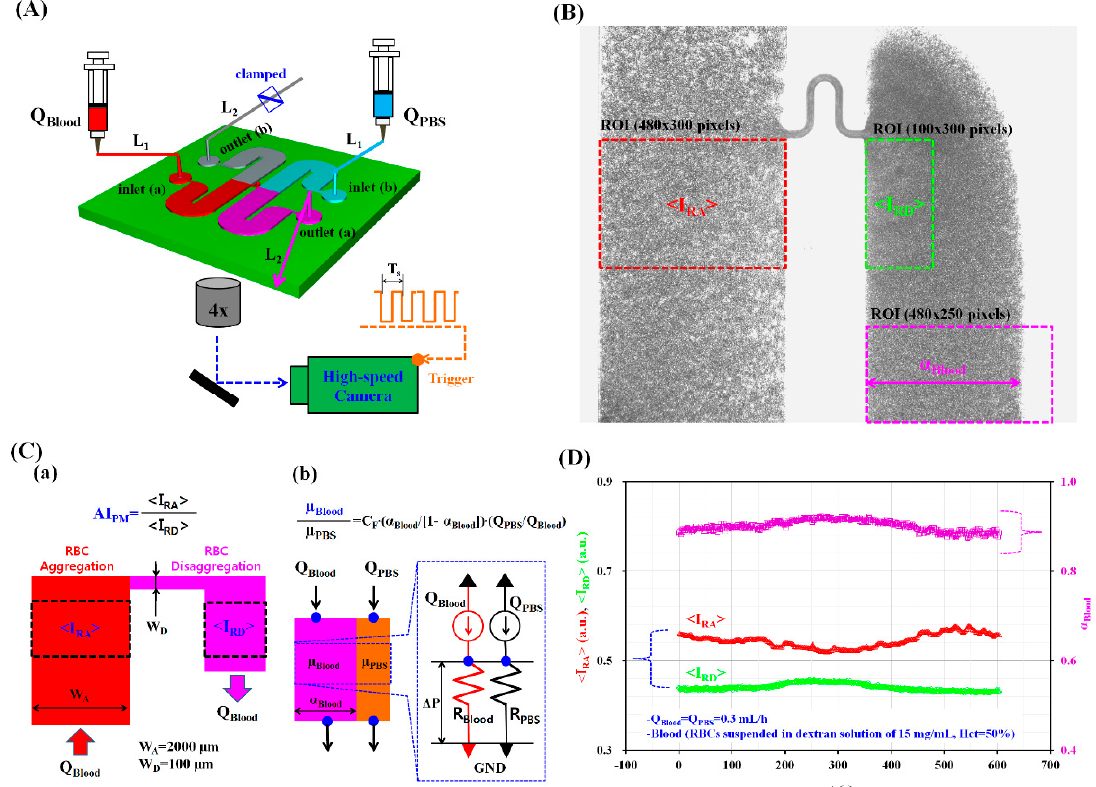
Figure 1. A proposed method for measuring red blood cells (RBCs) aggregation and blood viscosity in a continuous and simultaneous fashion. ( A ) Schematic diagram of an experimental setup including a microfluidic device, two syringe pumps, and microscopic image acquisition system with a high-speed camera. ( B ) Specific regions of interest (ROIs) for calculating three parameters: the image intensity of RBCs aggregated in the left wide channel (<I RA >), the RBCs disaggregated in the right wide channel (<I RD >) and the blood-filled width in the right wide channel ( α Blood ) from microscopic